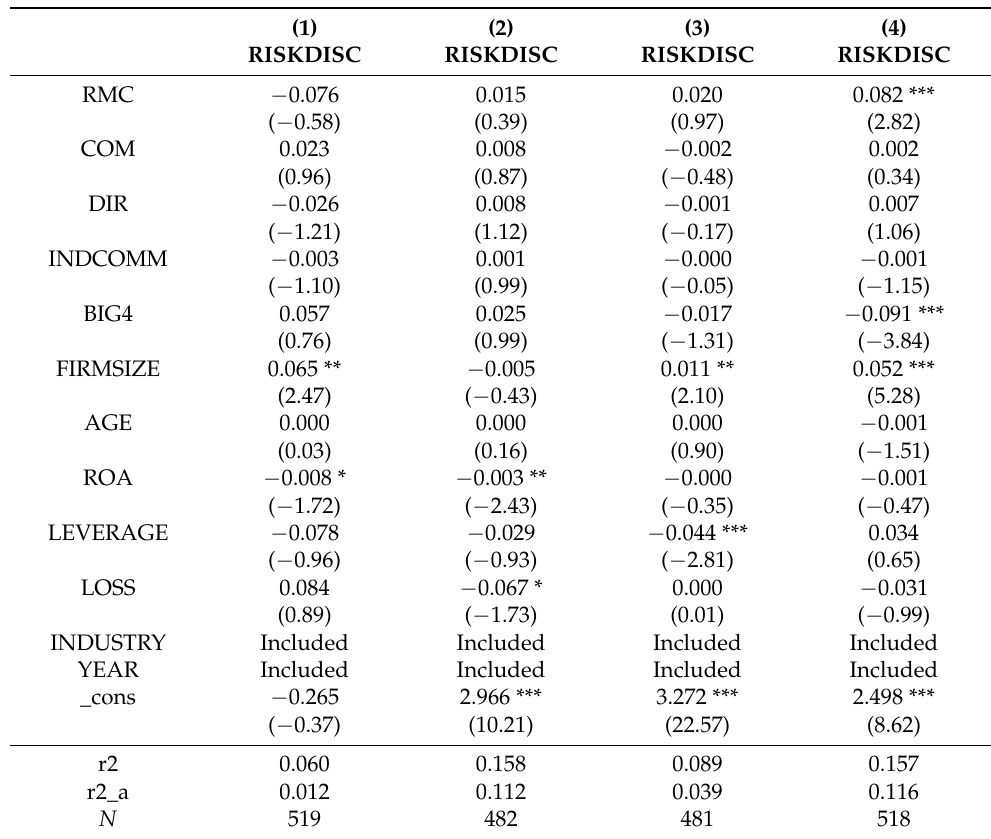
Table 8. Quartal analysis.